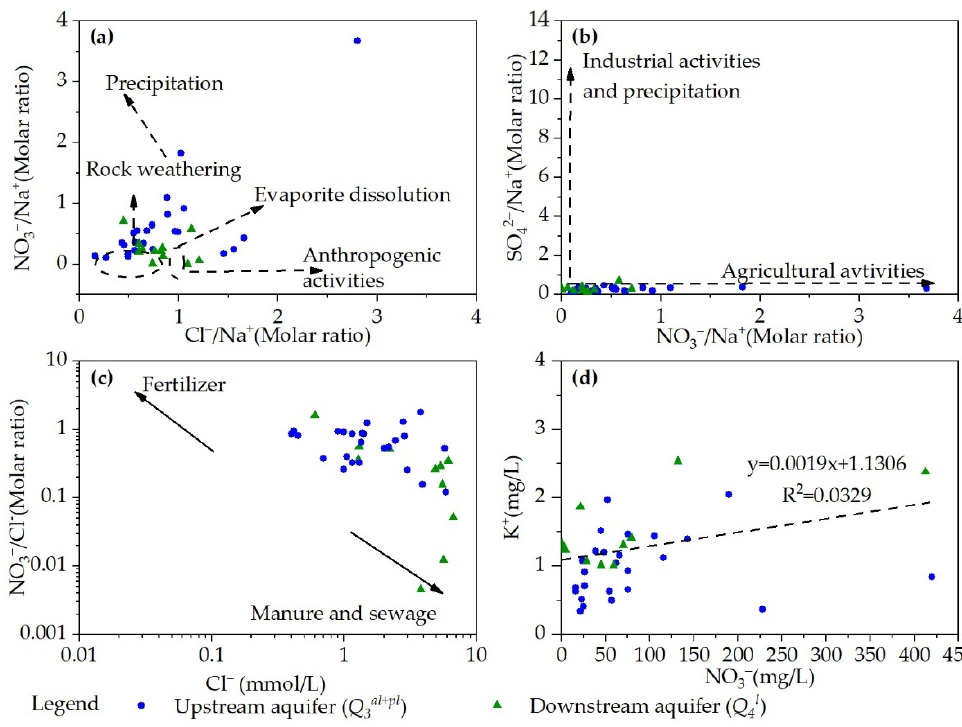
Figure 10. Relationships of (NO 3 − /Na + ) vs. (Cl − /Na + ) ( a ), (SO 42 − /Na + ) vs. (NO 3 − /Na + ) ( b ), (NO 3 − /Cl − ) vs. Cl − ( c ), and NO 3 − /K + ( d